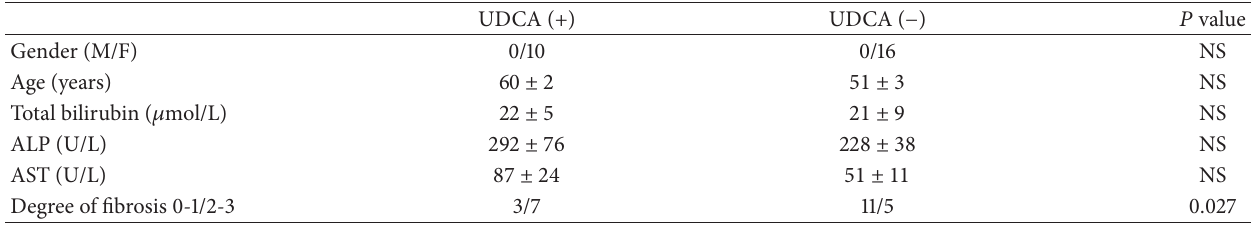
Table 2: Clinical data on non-cirrhotic patients with PBC who were and were not treated with UDCA. UDCA (+) UDCA ( − ) Gender (M/F)